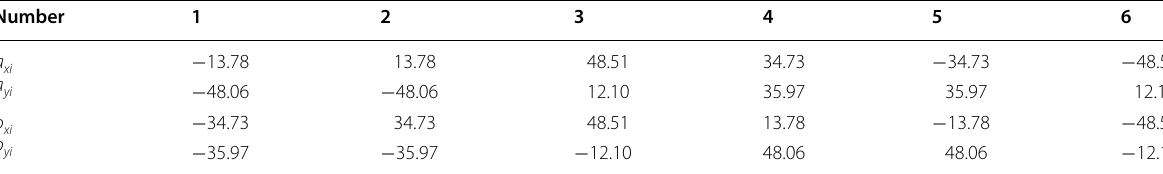
Table 1 Parameter settings (mm)